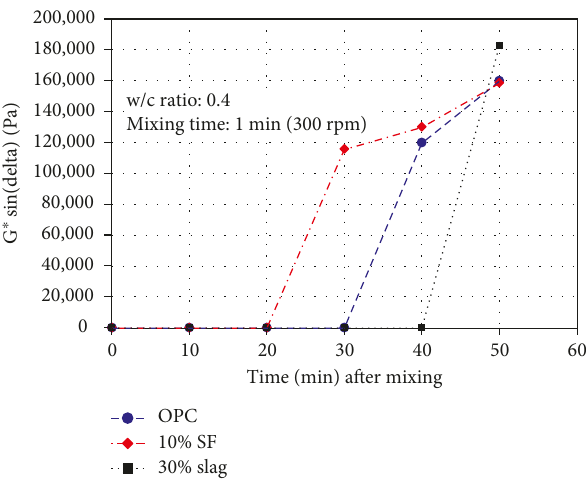
Figure 2: G sin(delta) with time after mixing (0.4w/c ∗